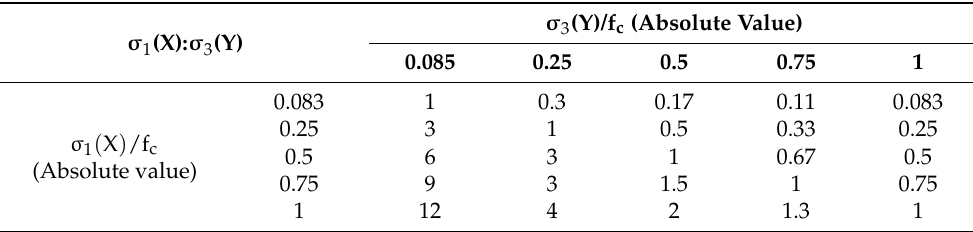
Table 3. Compressive stress ratios of the X-axis to the Y-axis